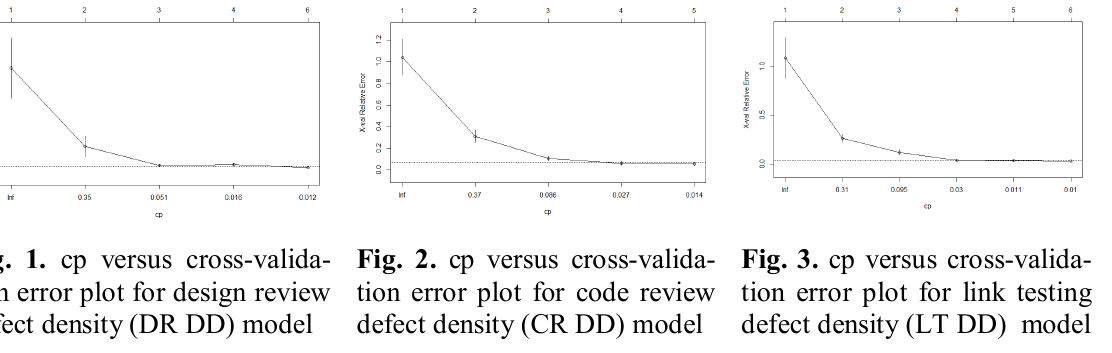
Fig. 2. cp versus cross-valida- tion error plot for code review defect density (CR DD) model